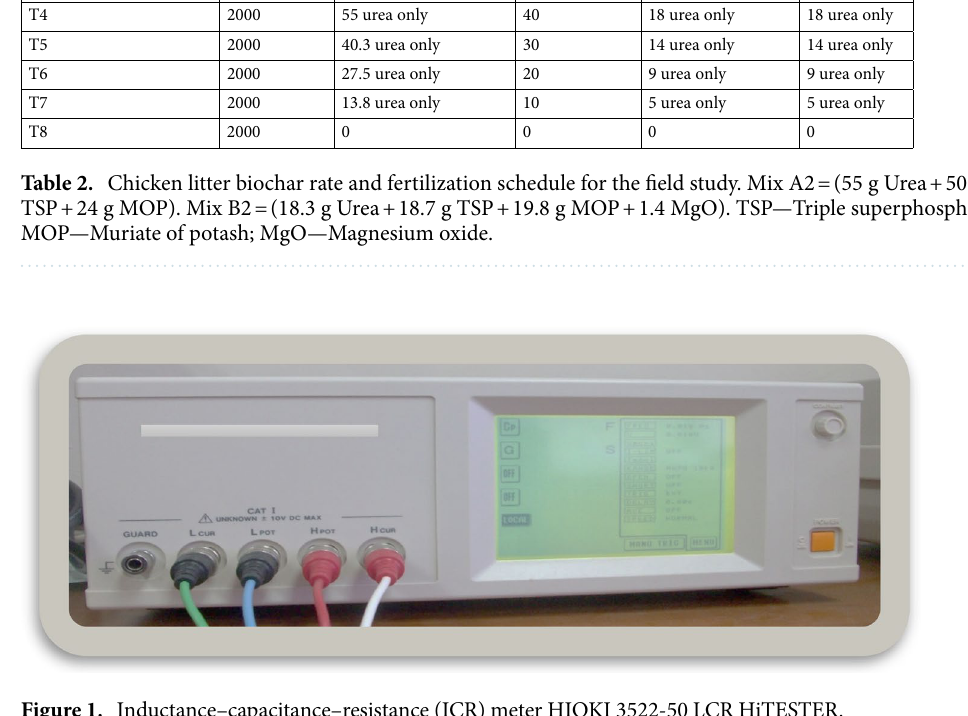
Figure 1. Inductance–capacitance–resistance (ICR) meter HIOKI 3522-50 LCR HiTESTER.